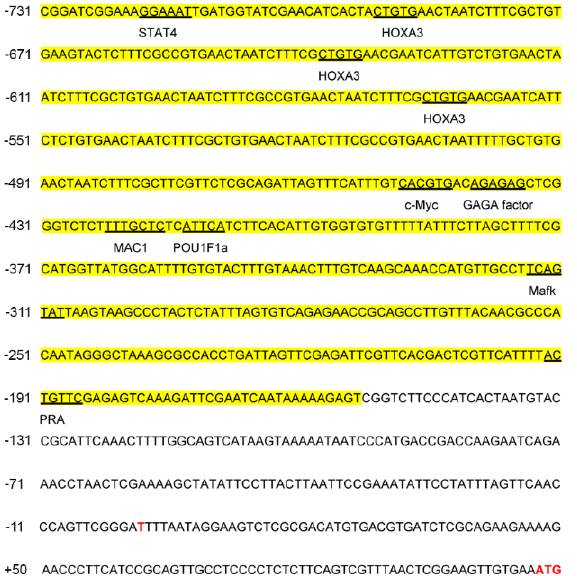
Figure 6. Nucleotide sequence of Cs-ewsr1-w promoter region ( − 911/+50) and the predicted transcription factor binding sites. The highly active region ( − 733/ − 154) was highlighted in yellow. Star codon “ATG” was labelled in red. Underlined boldface letters indicated the predicted transcription factors.